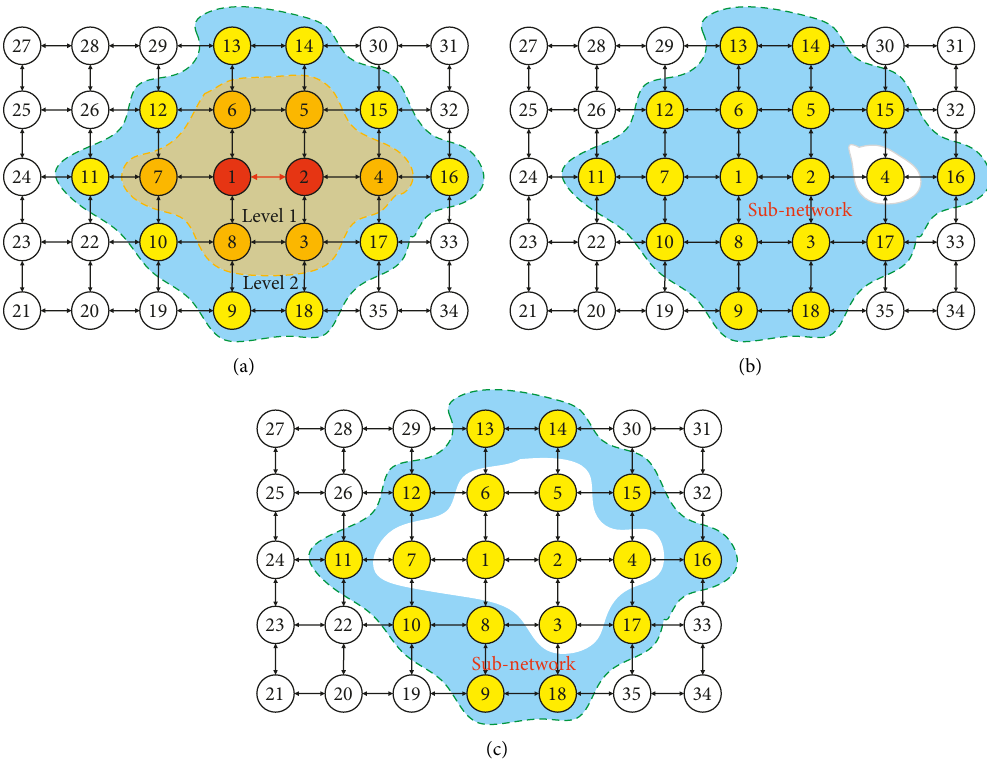
Figure 3: Examples of related concepts in the L-shell